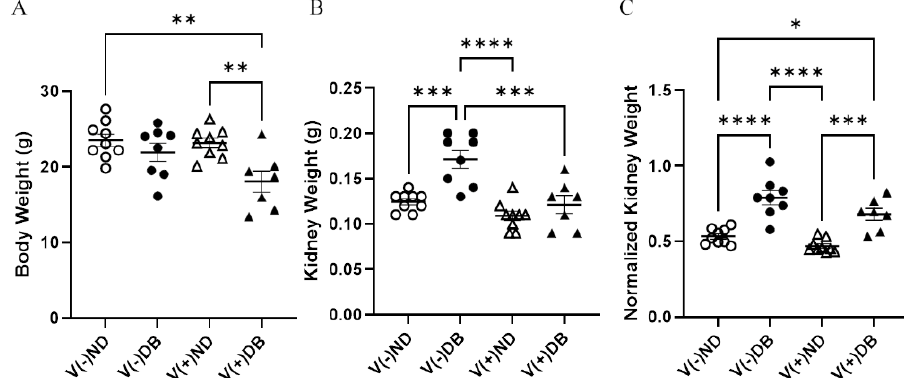
Figure 2. Body weight, kidney weight, and normalized kidney weight: ( A ) body weight, ( B ) kidney weight, and ( C ) normalized kidney weight were measured and compared across all four NOD mouse groups ( n = 7–9; * p < 0.05, ** p < 0.01, *** p < 0.001, **** p < 0.0001; V( − )ND, V( − )DB, V(+)ND, V(+)DB).